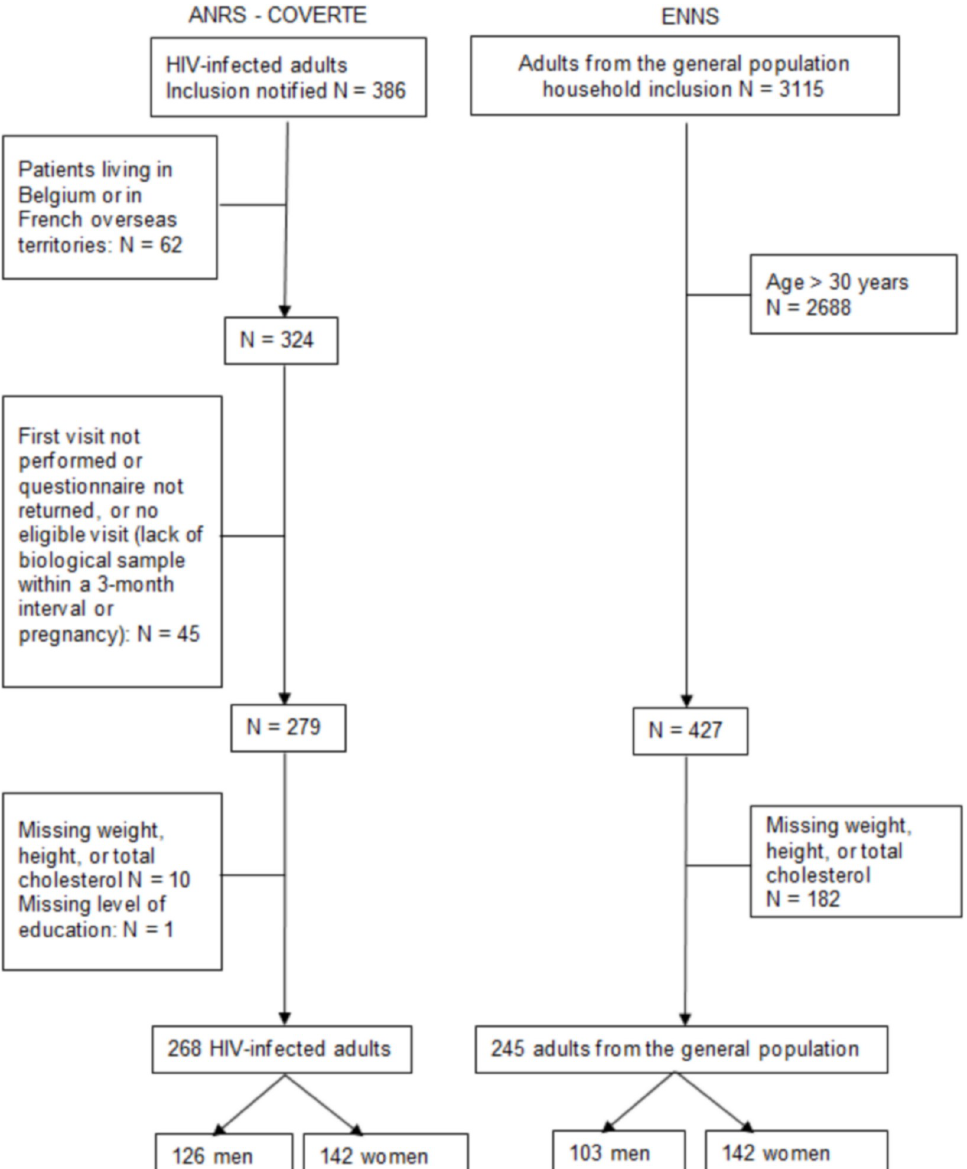
Fig 1. Diagram for sample selection from the ANRS-COVERTE CO19 cohort and ENNS